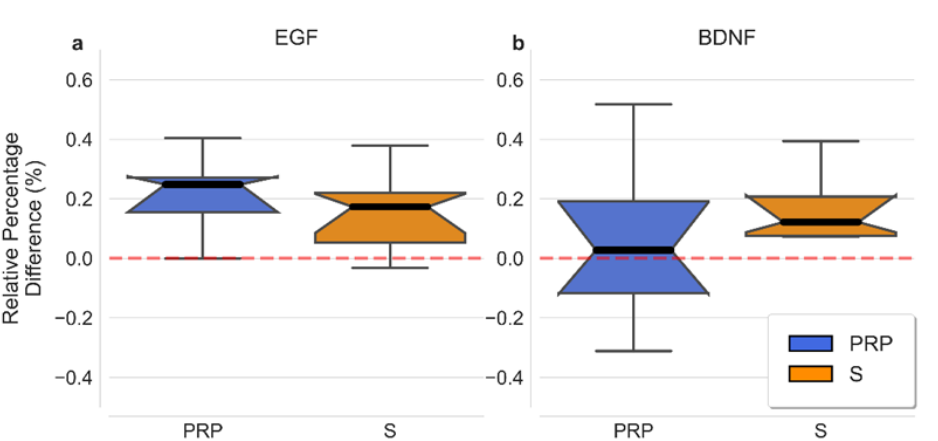
Figure 1. Distributions of the relative percentage values (i.e., the difference between FF and FD normalized by FF for the two preparations (PRP and S) in the two growth factors (( a ) EGF and ( b ) BDNF). PRP and S distributions are represented separately for comparison. Each distribution is represented independently. Minimum and maximum distributions are shown by lines and the median using an internal notch (representing the uncertainty of the median). The box spread represents the 1st and 3rd quartiles of distribution. EGF: Epithelial Growth Factor; BDNF: Brain-Derived Neurotrophic Factor; S: Serum; PRP: Platelet-Rich